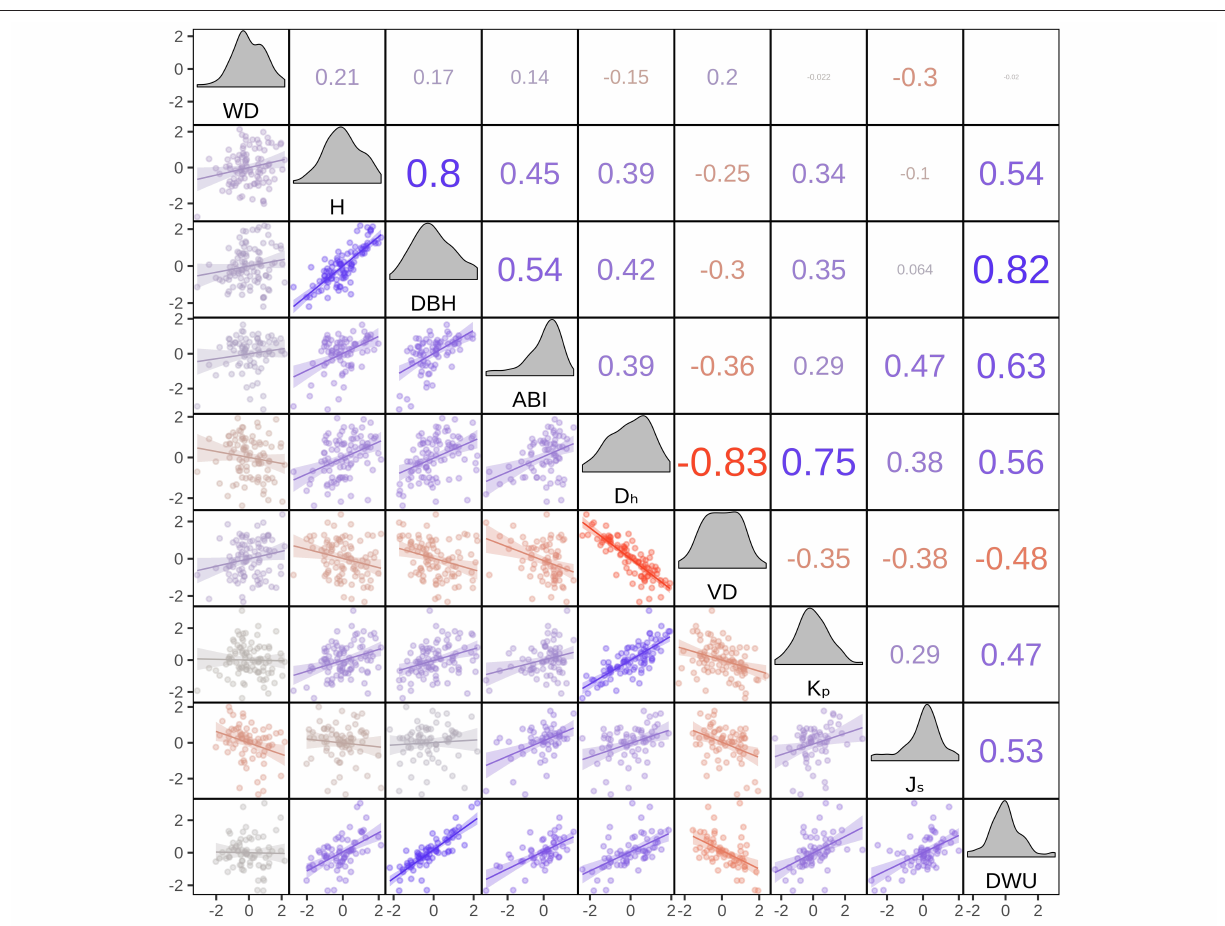
traits (cf. Figures 2 , 3 ) was fully explained by their effect on J s